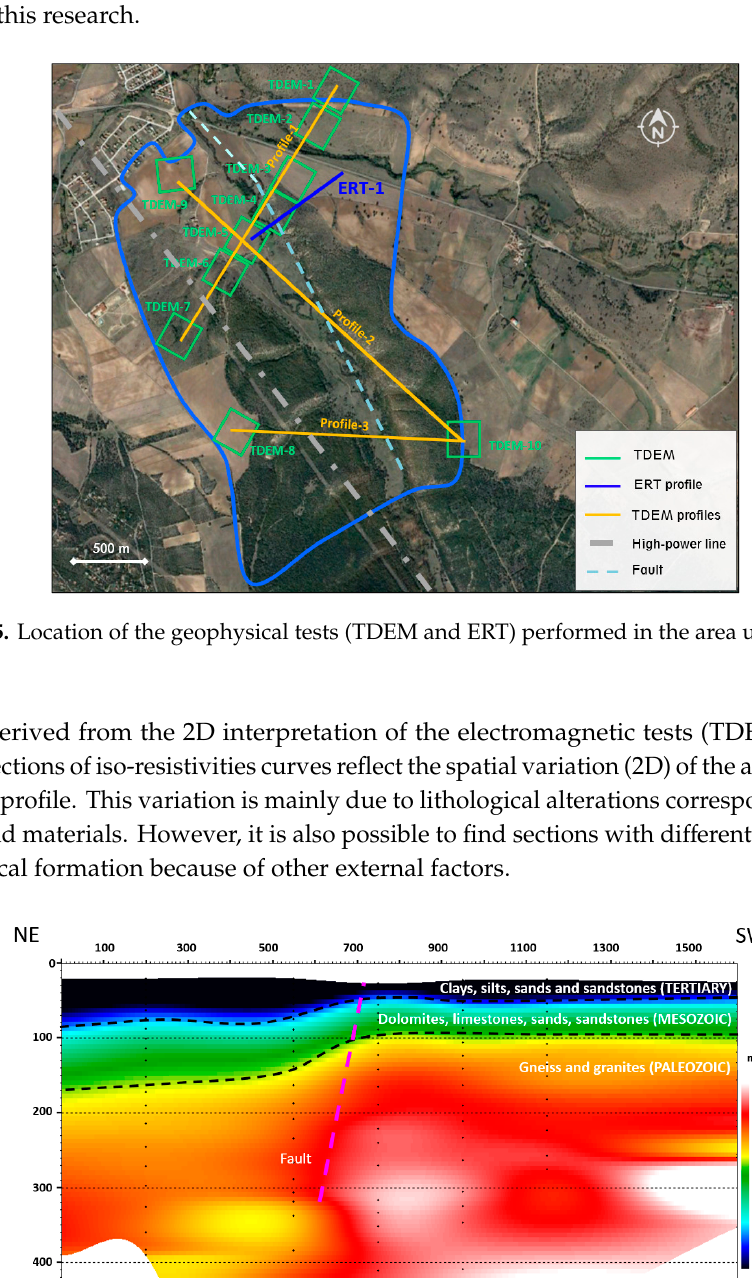
Figure 6. Two-dimensional interpretation of electromagnetic prospecting, TDEM-profile 1.